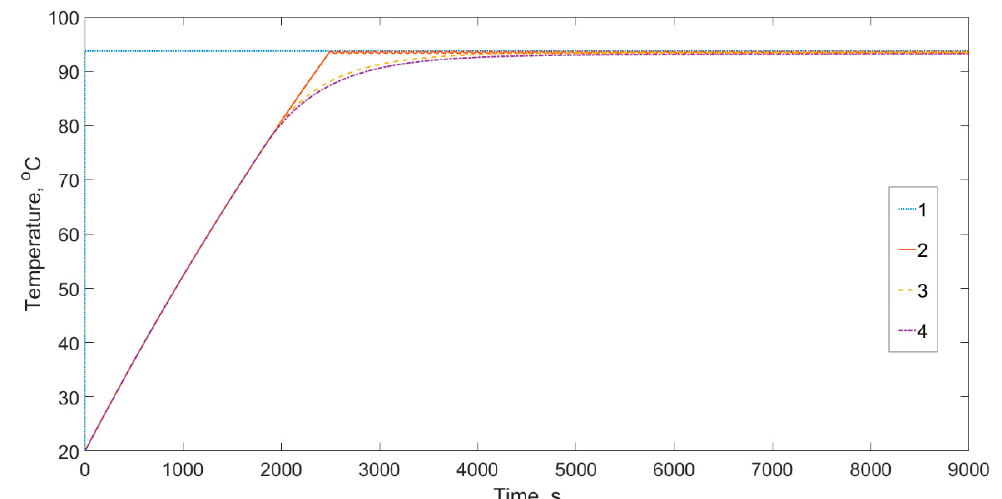
Figure 7. Results of the simulation of controlling the course of temperature—no noise: 1—value of the set temperature, 2—output signal of the control system with a relay controller, 3—output signal of the control system with a PID controller and 4—output signal of the control system with an I-PD controller.